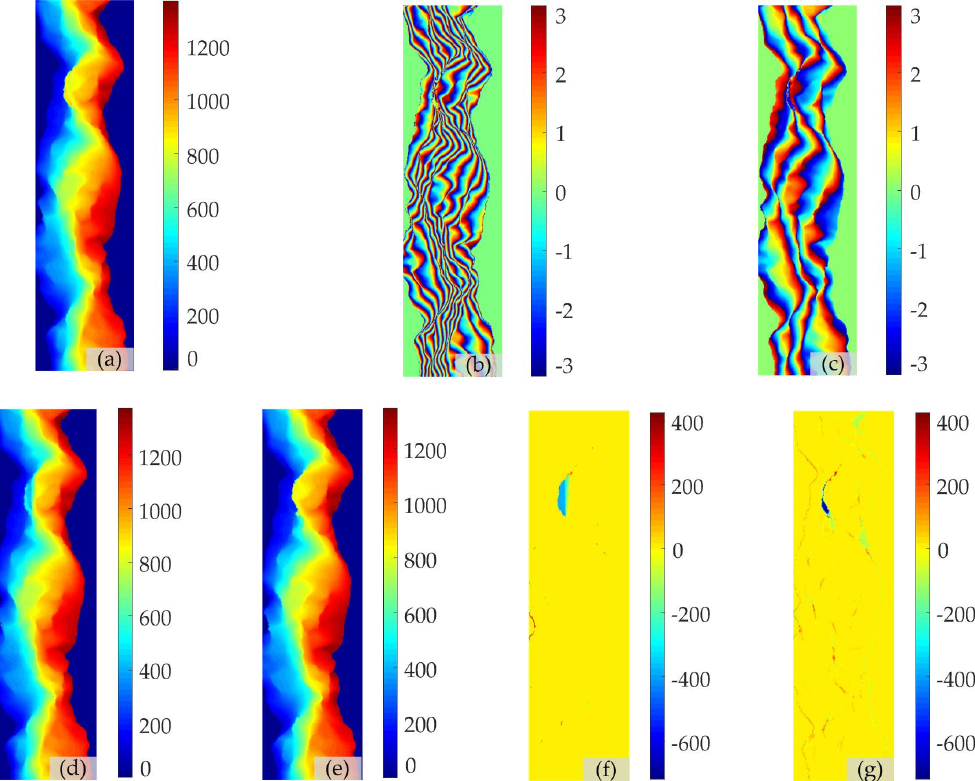
Figure 4. ( a ) Employed Digital elevation model (DEM) (unit: m). ( b ) Simulated interferogram with long normal baseline. ( c ) Simulated interferogram with short normal baseline. ( d ) Terrain height estimated by the phase unwrapping (PU) result of the two-stage programming approach (TSPA) method. ( e ) Terrain height estimated by the PU result of the TSPA- unscented Kalman filter (UKF) PU method. ( f ) Errors between (d) and (a). ( g ) Errors between (e) and (a).